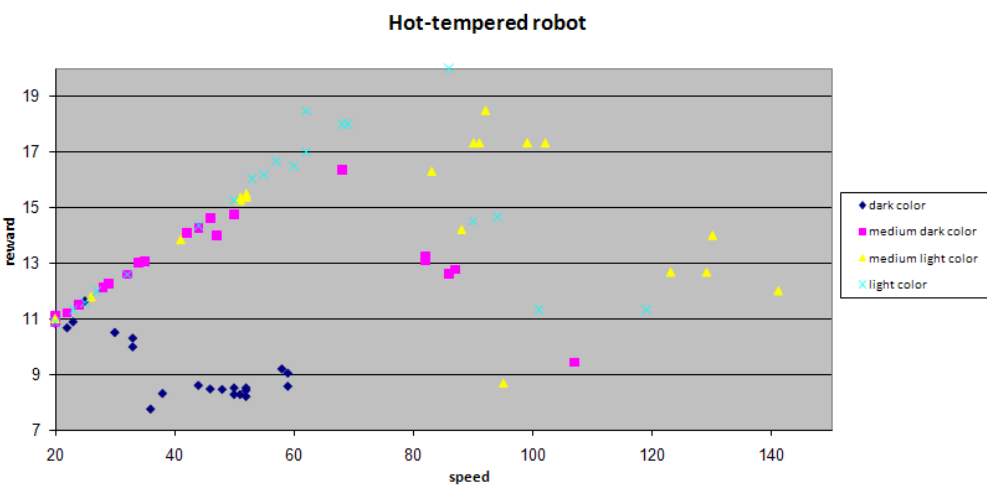
Figure 14. Performance of a hot-tempered robot against its